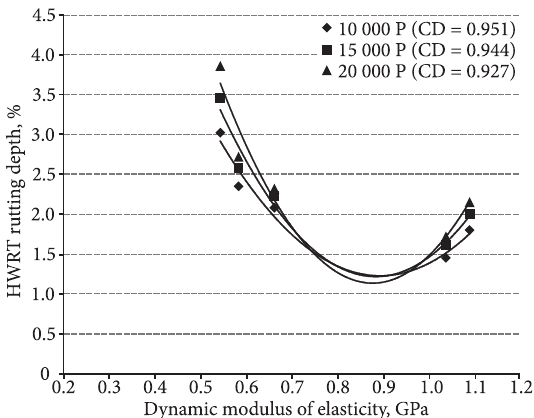
Fig. 1. Excellent relationships between dynamic modulus and HWRT rutting depth ( f = 0.1 Hz, T = +54.4 o C)